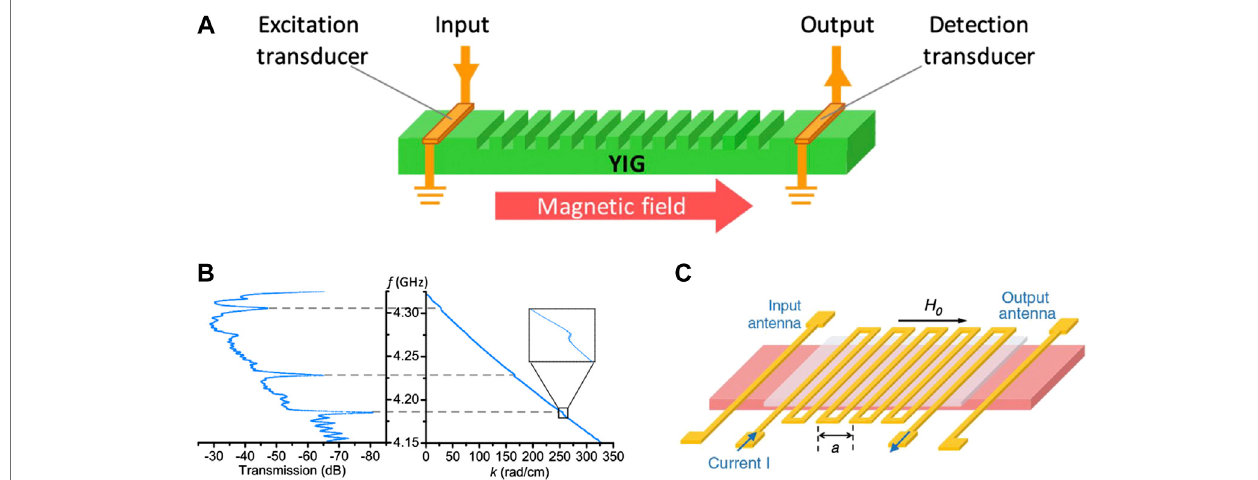
FIGURE 2 | (A) A static magnonic crystal with a groove array, where the width and height of the groove determine the propagation characteristics of the passing spinwaves(Richardsonetal.,2018).Reproducedwiththepermissionfromhttps://journals.aps.org/prl/abstract/10.1103/PhysRevLett.121.107204. (B) Thespin-wave propagation characteristics (left side) and the dispersion relationship (right side) of magnonic crystal in (A) . It is clearly seen that spin waves are forbidden to a certain extent at speci fi c frequencies (4.18, 4.23 and 4.3 GHz) known as “ band gaps ” while they can propagate freely in other frequencies (Richardson et al., 2018). Reproduced with the permission from https://journals.aps.org/prl/abstract/10.1103/PhysRevLett.121.107204. (C) A schematic diagram of dynamic magnonic crystal based on current regulation; by changing the current, the transverse magnetic fi eld of the magnetic crystal is also changed, thus the propagation characteristics of the passing spin waves can be adjusted (Rana and Otani, 2019) (licensed under CC BY